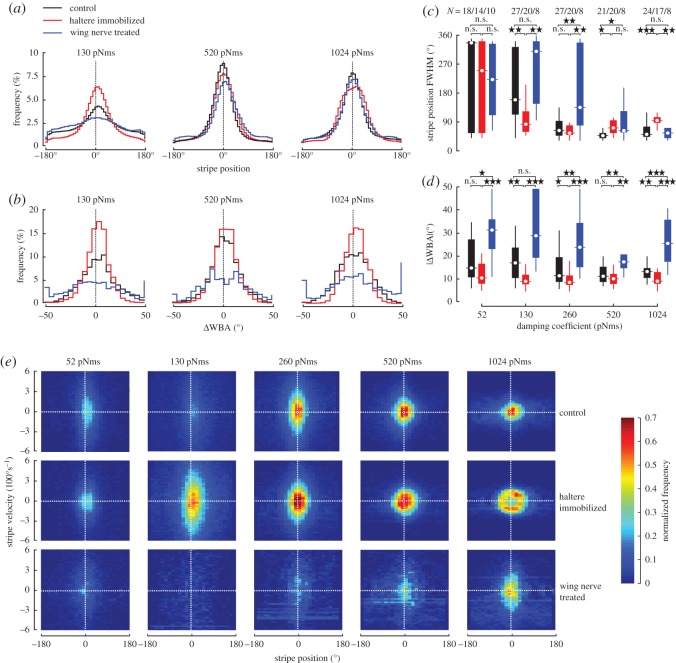
Statistical evaluation of object fixation response. (a) Normalized histograms of mean stripe position and (b) corresponding mean ΔWBA of the tested groups at three selected damping coefficients. Mean standard deviation is in (a) 1.27% (black), 0.96% (red) and 1.01% (blue) and in (b) 2.33% (black), 1.77% (red) and 4.11% (blue). ±180°, rear position; 0°, frontal position of the panorama. (c) Tukey box plots of half width stripe position histograms (full width at half maximum, FWHM) and (d) mean absolute WBA differences within a flight sequence for all tested damping coefficients. Black, intact controls; red, haltere-immobilized flies; blue, wing nerve treated flies; N, number of tested flies; n.s., not significant. (e) Phase space plots of angular velocity of the visual object (black stripe) displayed inside the flight simulator plotted against object position at five aerodynamic damping coefficients. 0° and ±180° indicate the fly’s frontal and rear field of view, respectively. For each graph, we averaged 2000 flight samples each of 8–24 flies (see c) and sorted them into 80 velocity and 25 position bins. Normalized frequency of data points is plotted in pseudo-colour.